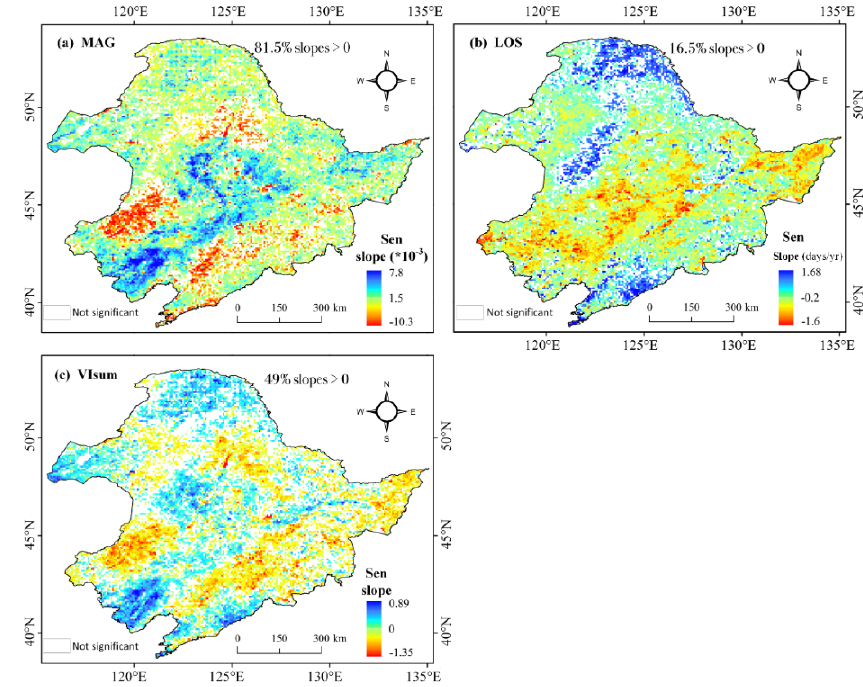
Figure 4. Spatial distribution of Theil-Sen Trends for MAG ( a ), LOS ( b ) and VIsum ( c ), (LOS units: days/year; MAG and VIsum are unitless, significance level: p value < 0.05)